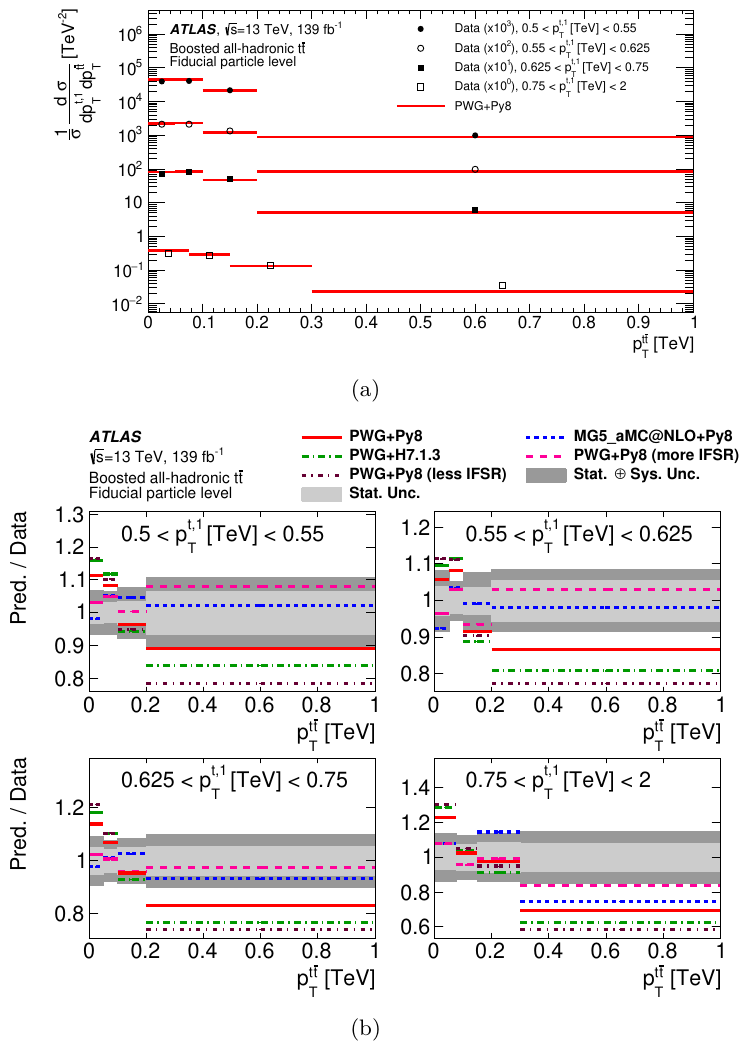
Figure 15 . (a) Normalized particle-level fiducial phase-space double-differential cross-sections as a function of the p T of the leading top-quark jet and the p T of the t ¯ t final state, p t ¯ t with the Powheg+Pythia 8 calculation. Data points are placed at the centre of each bin and the Powheg+Pythia 8 calculation is indicated by solid lines. The measurement and the prediction are normalized by the factors shown in parentheses to aid visibility. (b) The ratios of various MC calculations to the normalized particle-level fiducial phase-space differential cross-sections. The dark and light grey bands indicate the total uncertainty and the statistical uncertainty, respectively, of the data in each